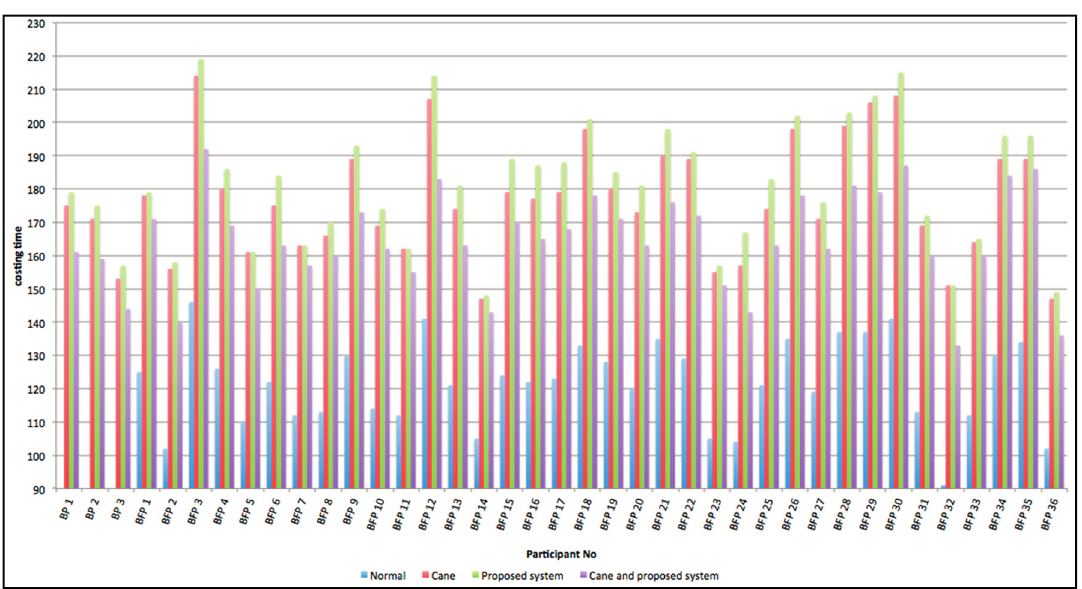
Figure 29. The statistical data of